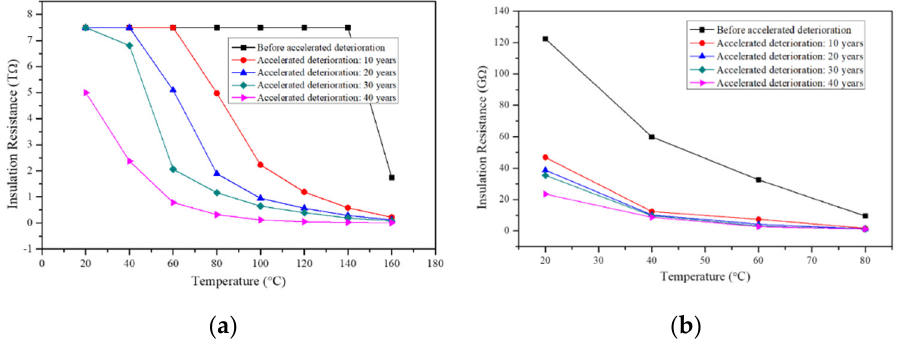
Figure 6. Insulation resistance characteristics according to temperature of the accelerated deteriorated cables. ( a ) TFR-8 cable, ( b ) VCTF cable.